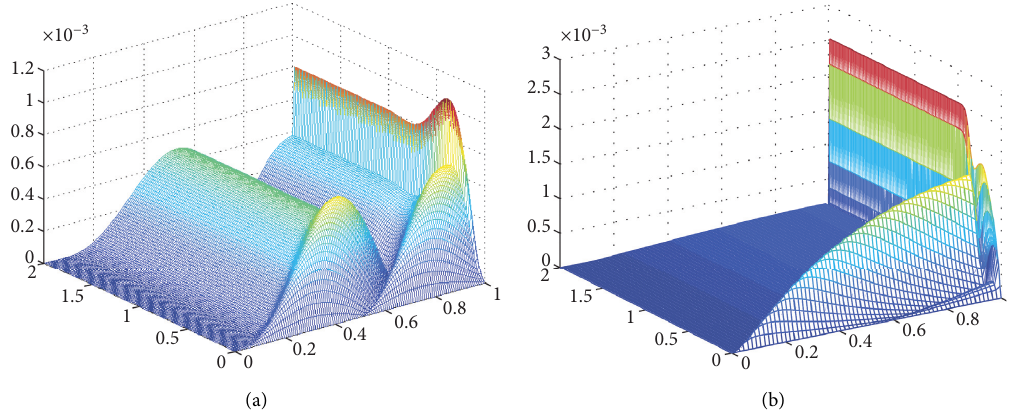
Figure 5: Absolute error on (a) Example 1 and on (b) Example 2 for ε � 2 − 20 ,N � M � 2 7